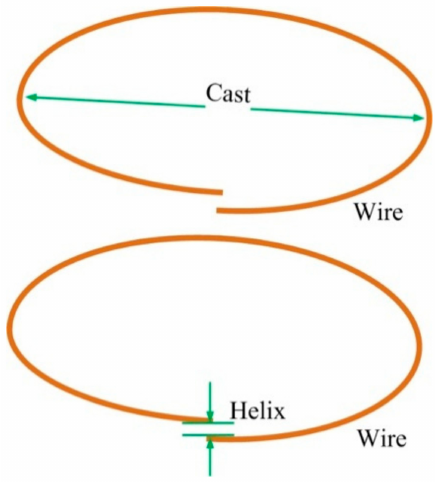
Figure 11. Cast and helix in a gas metal arc welding (GMAW) wire